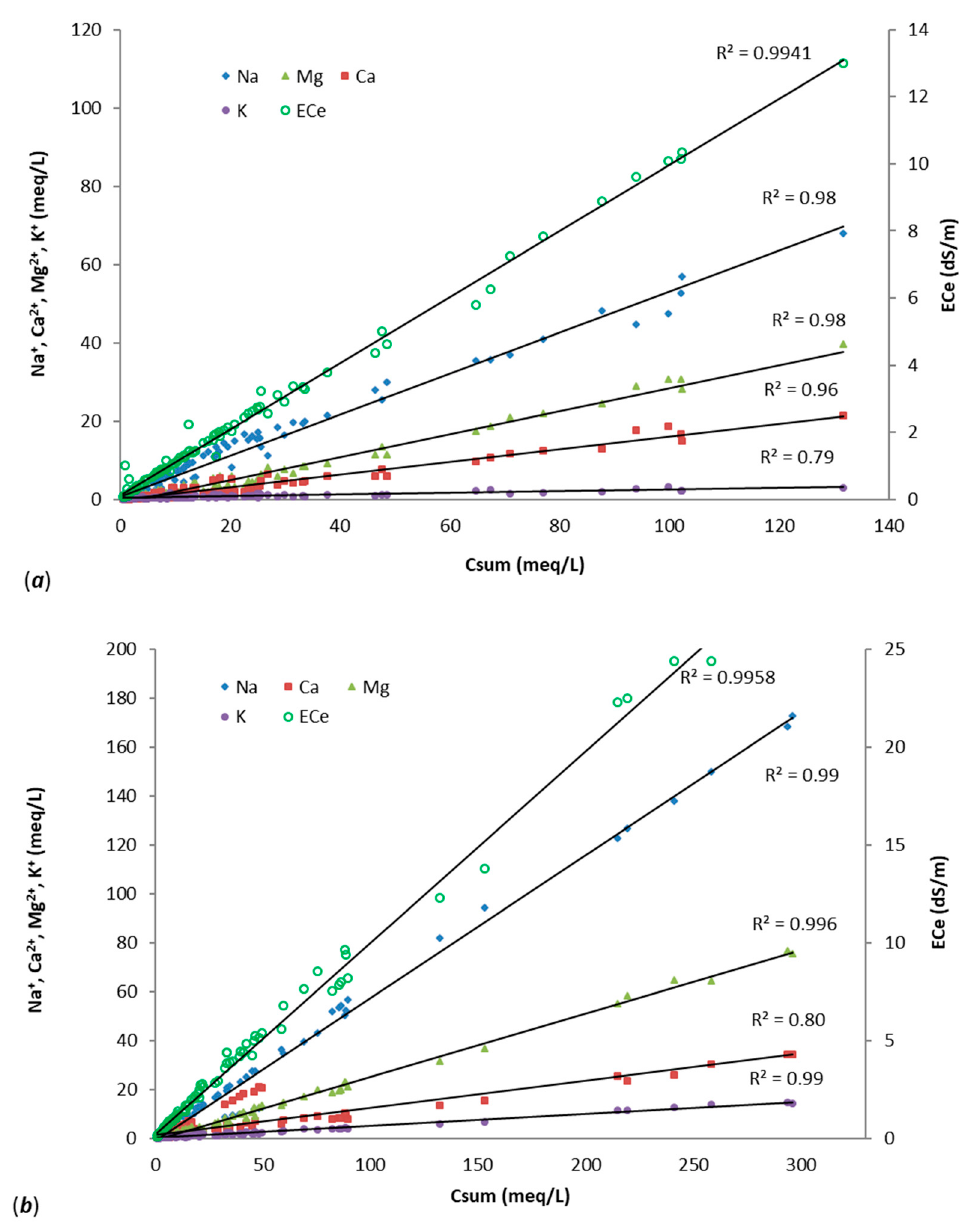
Figure 9. Relationships of concentration of total cation (C sum ) with EC e , and concentration of indi- vidual cation in the saturated paste extract from soil samples collected from depths 0 to 0.3 m after 330 days of column study from ( a ) D33 paddock soil columns ( b ) Yarramundi paddock soil